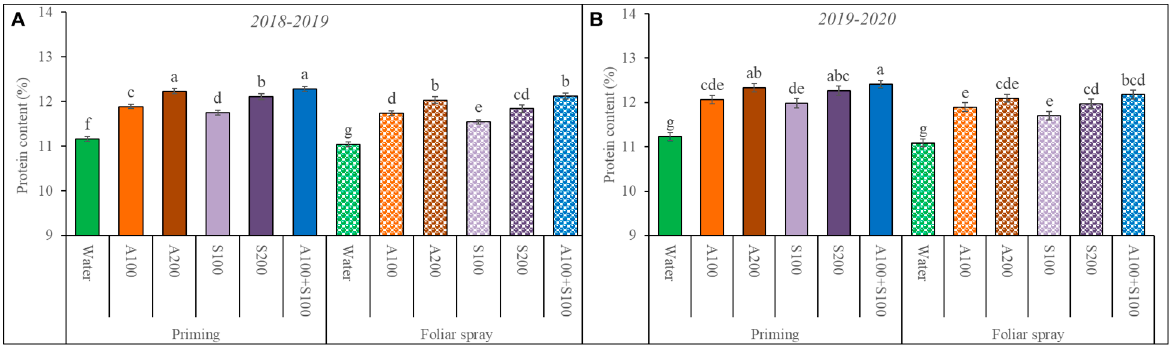
Figure 8. Effect of foliar spray and priming with antioxidant AA and SA on the protein content of wheat seeds in the two winter seasons ( A ) 2018/2019 and ( B ) 2019/2020. Data are mean ± standard error ( n = 4). Letters represent significant differences between treatments at p < 0.05 level according to the LSD test.